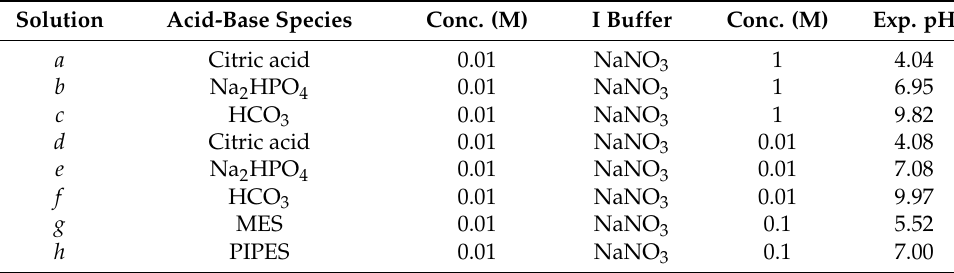
Table 3. Solutions used for the robustness samples ( a – i